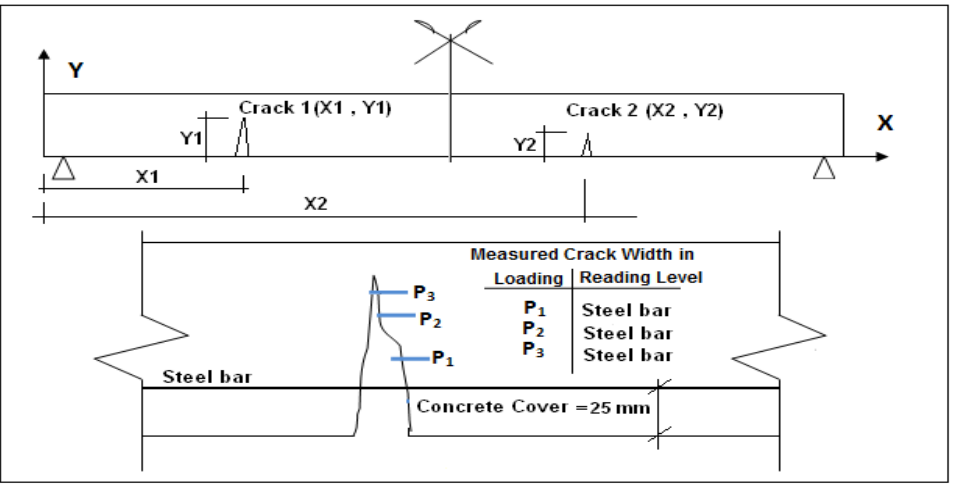
Figure 11. Measuring reference for the location and width provided in Tables 9–11 and Figure 8. Table 9. Crack widths and their locations for the S512-1100 and S512-700 specimens.